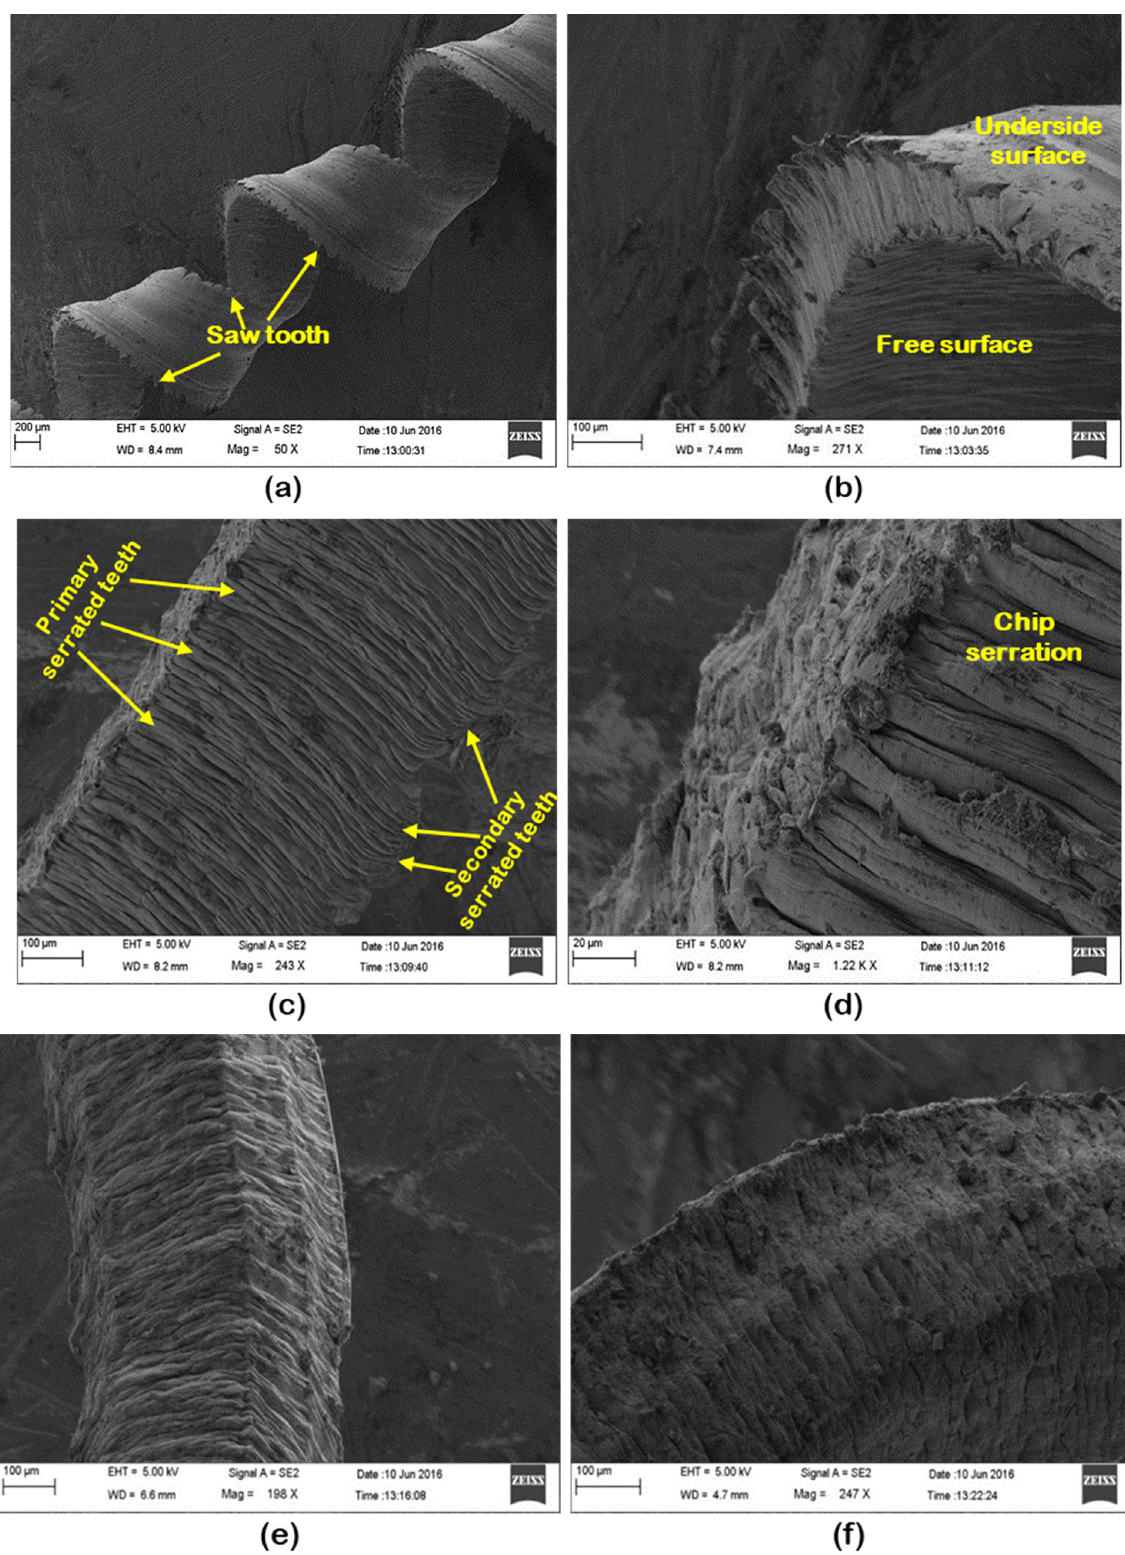
Figure 11. Chip morphology at: ( a ) V = 247 m/min, d = 0.4 mm, f = 0.10 mm/rev; ( b ) V = 247 m/min, d = 0.1 mm, f = 0.28 mm/rev; ( c ) V = 170 m/min, d = 0.3 mm, f = 0.10 mm/rev; ( d ) V = 146 m/min, d = 0.2 mm, f = 0.10 mm/rev; ( e ) top view of chip; and ( f ) bottom view chip at V = 146 m/min, d = 0.2 mm, f = 0.10 mm/rev.